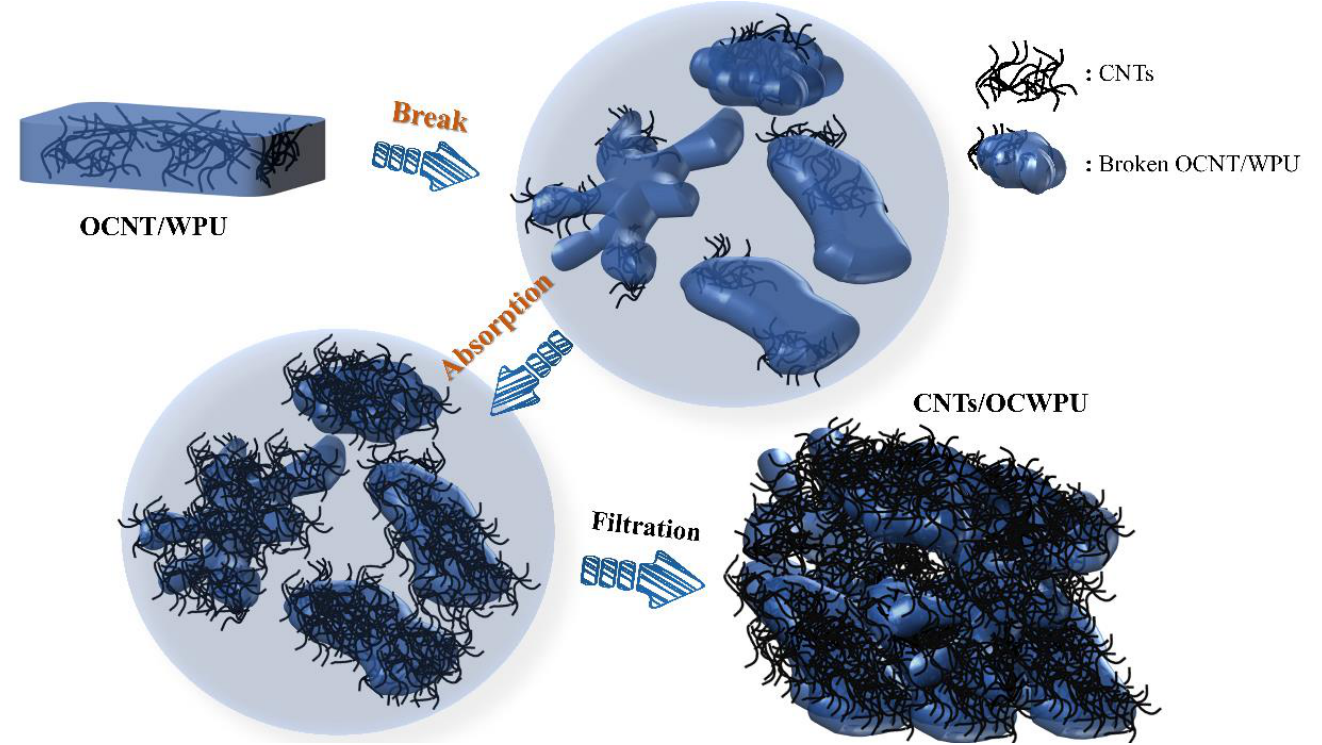
Figure 6. Schematic diagram of the process of CNTs/OCWPU preparation by “ broken-adsorption”. In OCNT/WPU, OCNT were grafted into polyurethane molecular chains. Due to the structure of CNTs, they tend to form clusters, which are more prone to stress points in the polyurethane matrix. When the OCNT/WPU was subjected to high shear force, these sites of OCNT agglomeration were first destroyed, rather than the sites bound to the polyurethane matrix by chemical bonds. Due to the uneven distribution of OCNT in the polyurethane matrix, the flocculated structures formed are also of different sizes, as shown in Figure 5. These exposed OCNT are equivalent to one site, and the later added CNTs are assembled in one OCNT site in the polyurethane matrix, and at the same time, there are some intermolecular forces adsorbed on the polyurethane surface. Like the Fang Zhi cypress growing at an altitude of 3500 m in the Four Girls Mountains in Aba Prefecture, Sichuan Province, China, the surface of its branches is covered with moss all over. the OCNT in OCWPU grow in the polyurethane matrix like fungi, and with the increase in on the flocculated surface of polyurethane, with CNTs interlocking and stacked to form a rosette-like scale. In Figure 7, two characteristic peaks of the C-atom crystal can be seen, the D-peak and the G-peak. The D-peak represents a defect in the C-atom lattice and the G-peak represents the in-plane stretching vibration of the C-atom sp2 hybridization